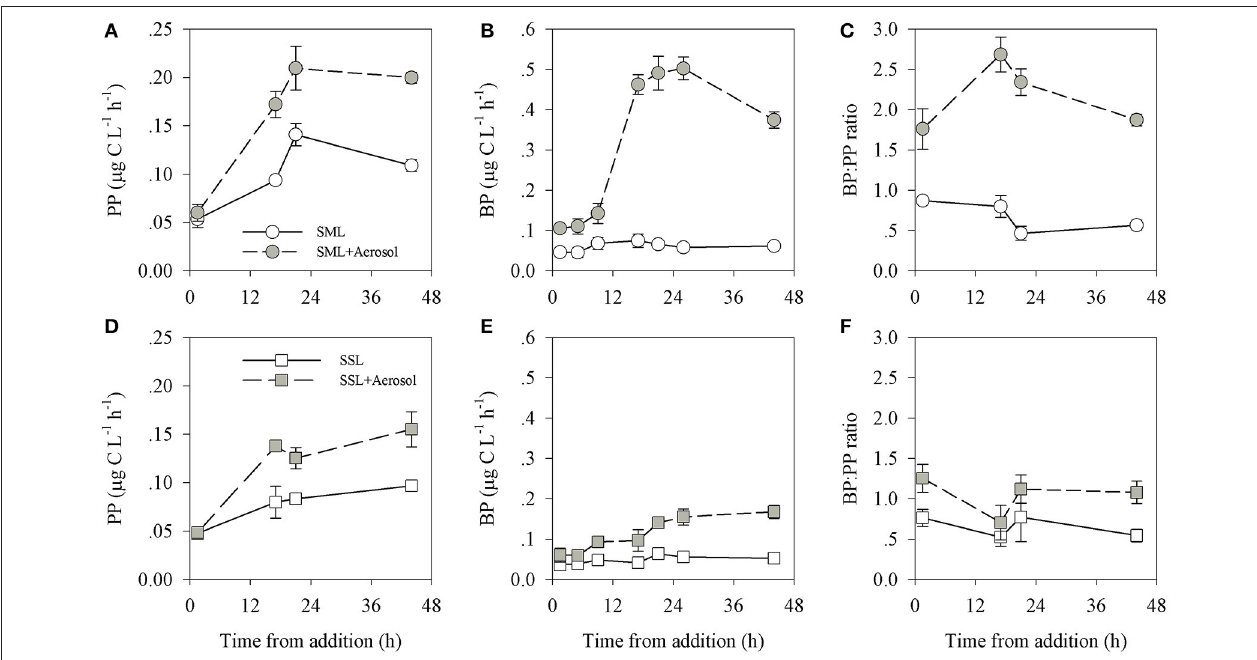
FIGURE 3 | Temporal dynamics of primary production (A,D) , bacterial production (B,E) and the BP: PP ratio (C,F) in the SML (A–C) and SSL (D–F) layers. Experiments including aerosol additions (1.5mg L − 1 ) are presented in gray, control experiments (containing no additions) are colored white. Values are the averages and standard deviation from 3 biological replicates ( n = 3).